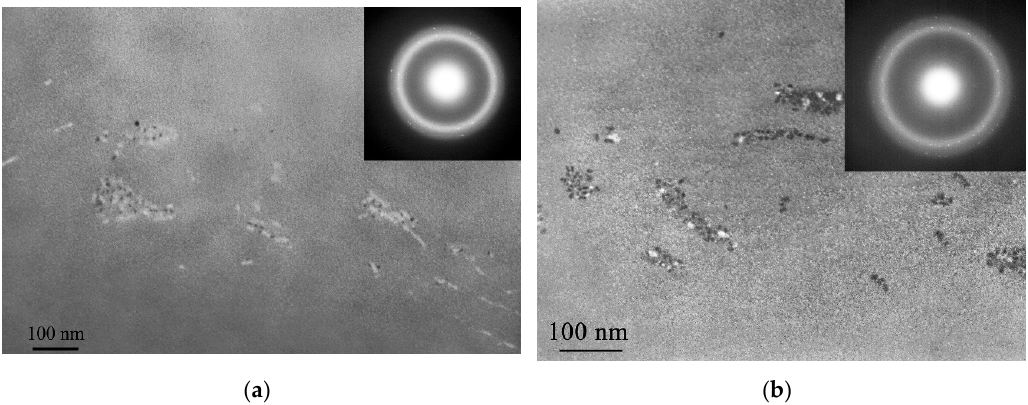
Figure 14. Microstructure of Al85.1Ni6Co2Gd6Si0.9 alloy sample ( a ) after rolling and ( b ) after ageing at room temperature ) [reproduced from Acta Materialia, 2008, 56, 2834 with permission from Elsevier, 2020] [83].